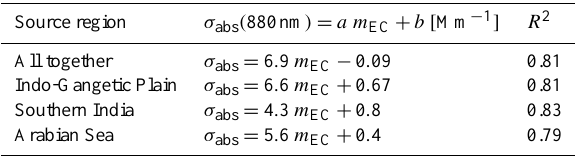
Table 4. Relation between the particle absorption coefficient at 880nm and the PM 2 . 5 EC mass concentration for different source